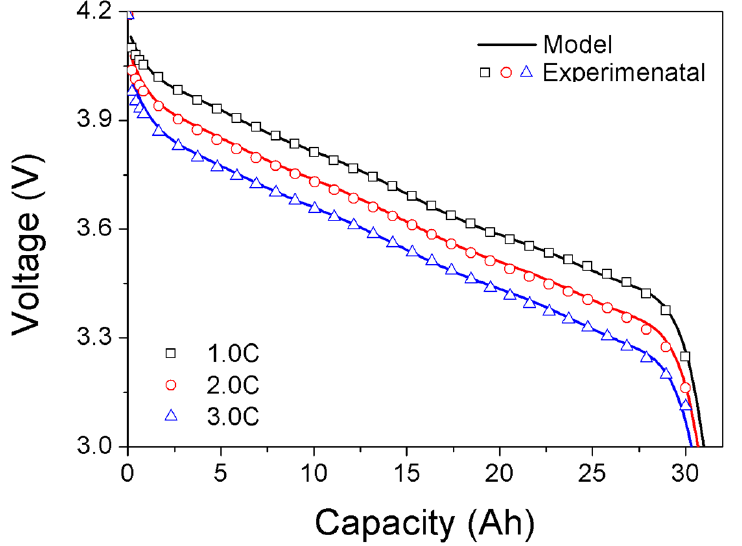
Figure 1. Comparison between experimental and modeling discharge curves at discharge rates of 1, 2, and 3 C. Open symbols are experimental data and solid lines are modeling results.